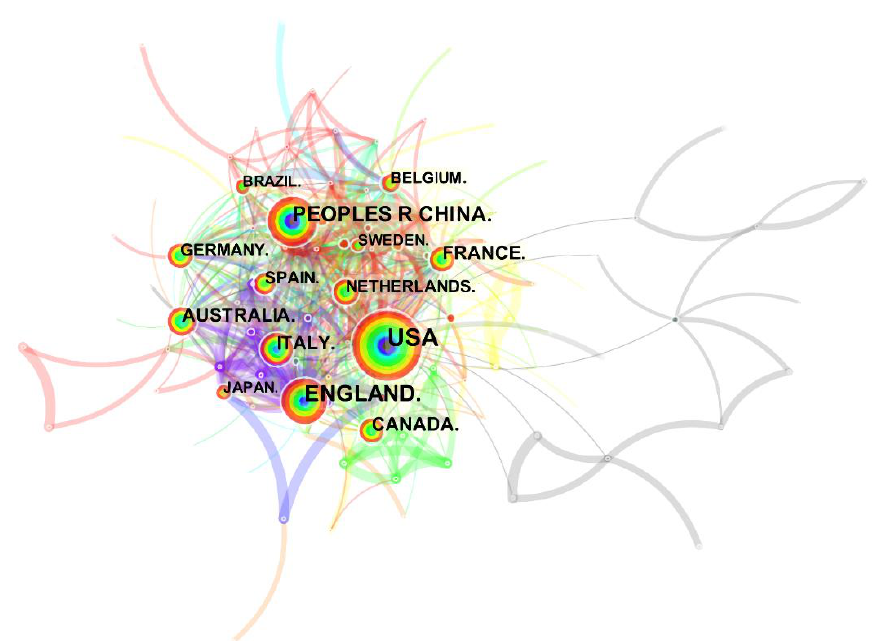
Figure 3. A network map showing national collaborations in soundscape research.